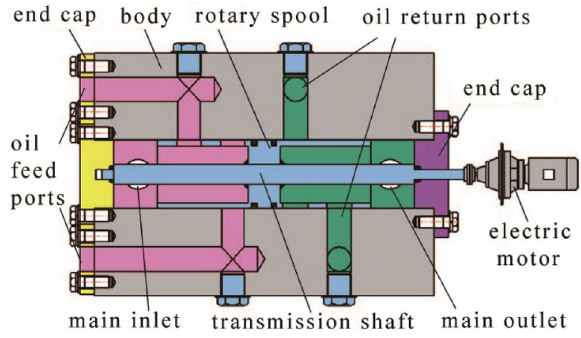
Fig. 1 Process flow